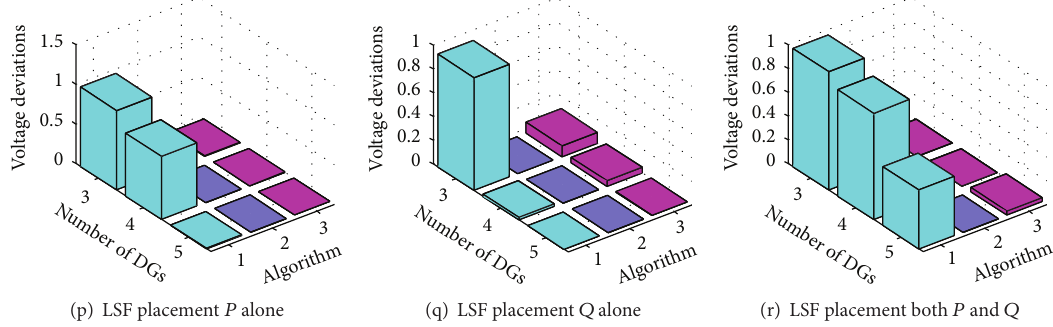
Figure 4: Algorithms used versus number of DGs placed for 𝑃 𝑙 , 𝑄 𝑙 , and VD.